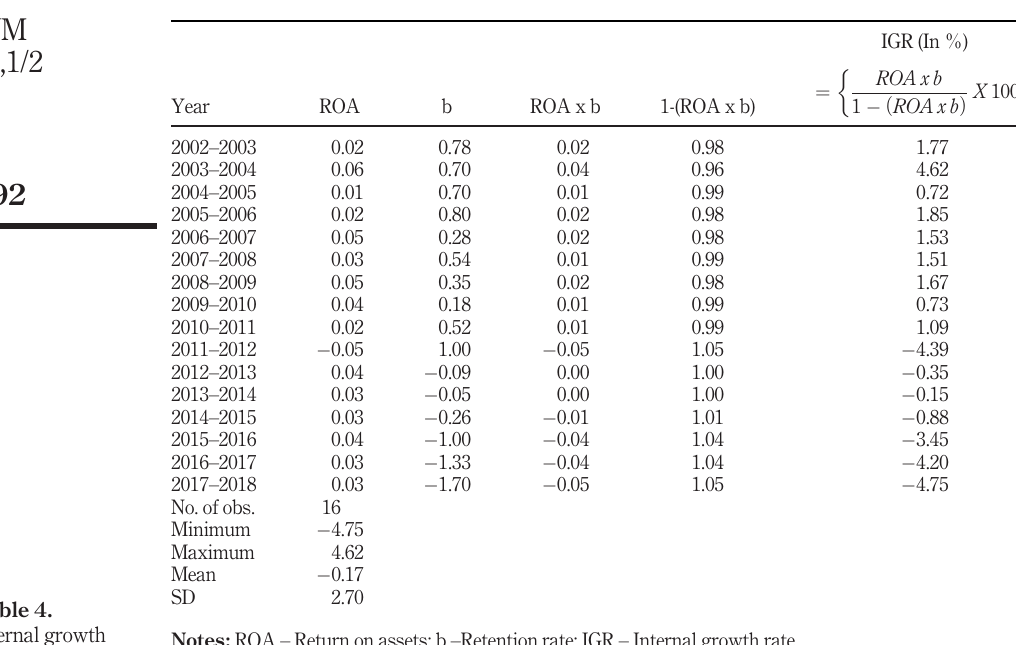
Table 4. Internal growth capacity of GIC